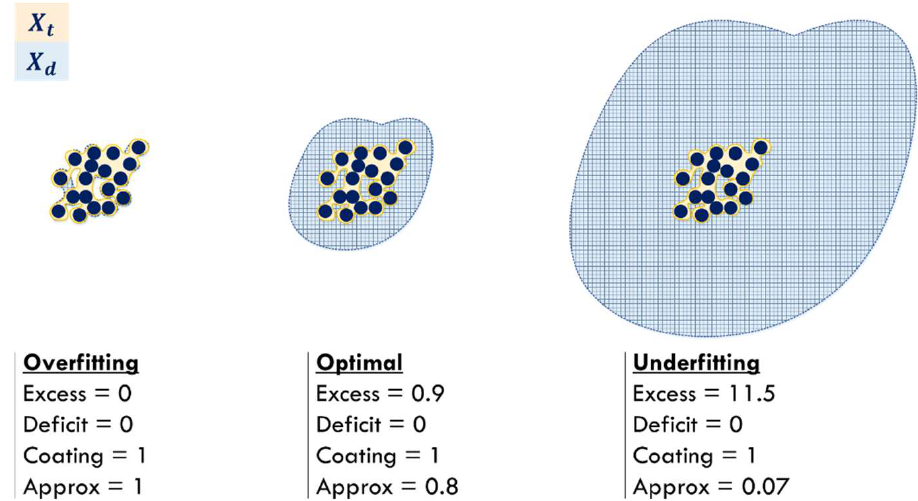
Figure 3. The relationship between the size of the 𝑋 (cid:3005)∗ area and the values of the EDCA characteris- tics.